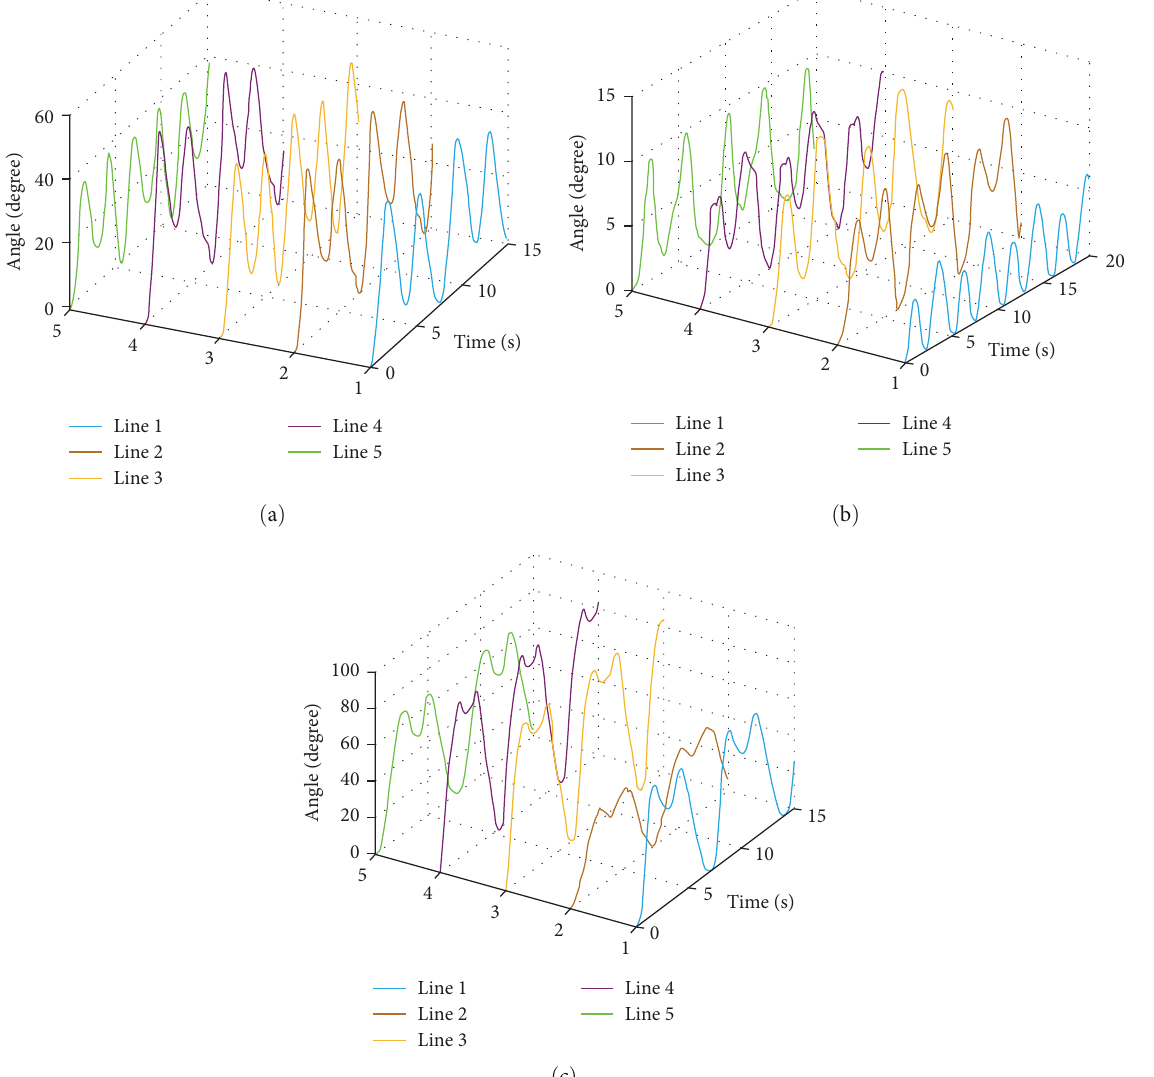
Revolving platform